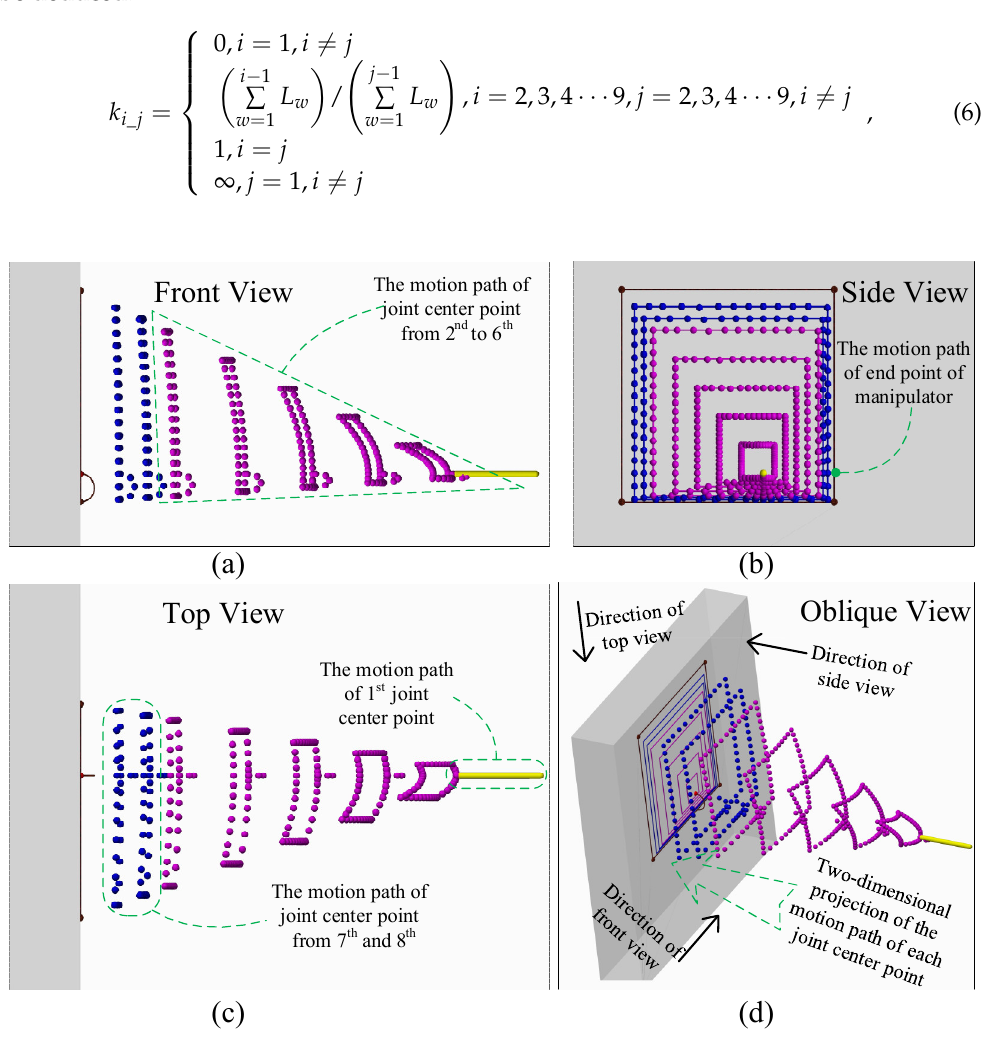
Figure 4. The 3D paths and 2D projections of all joint center points. ( a ) Front view; ( b ) Side view; ( c ) Top view; ( d ) Oblique view.